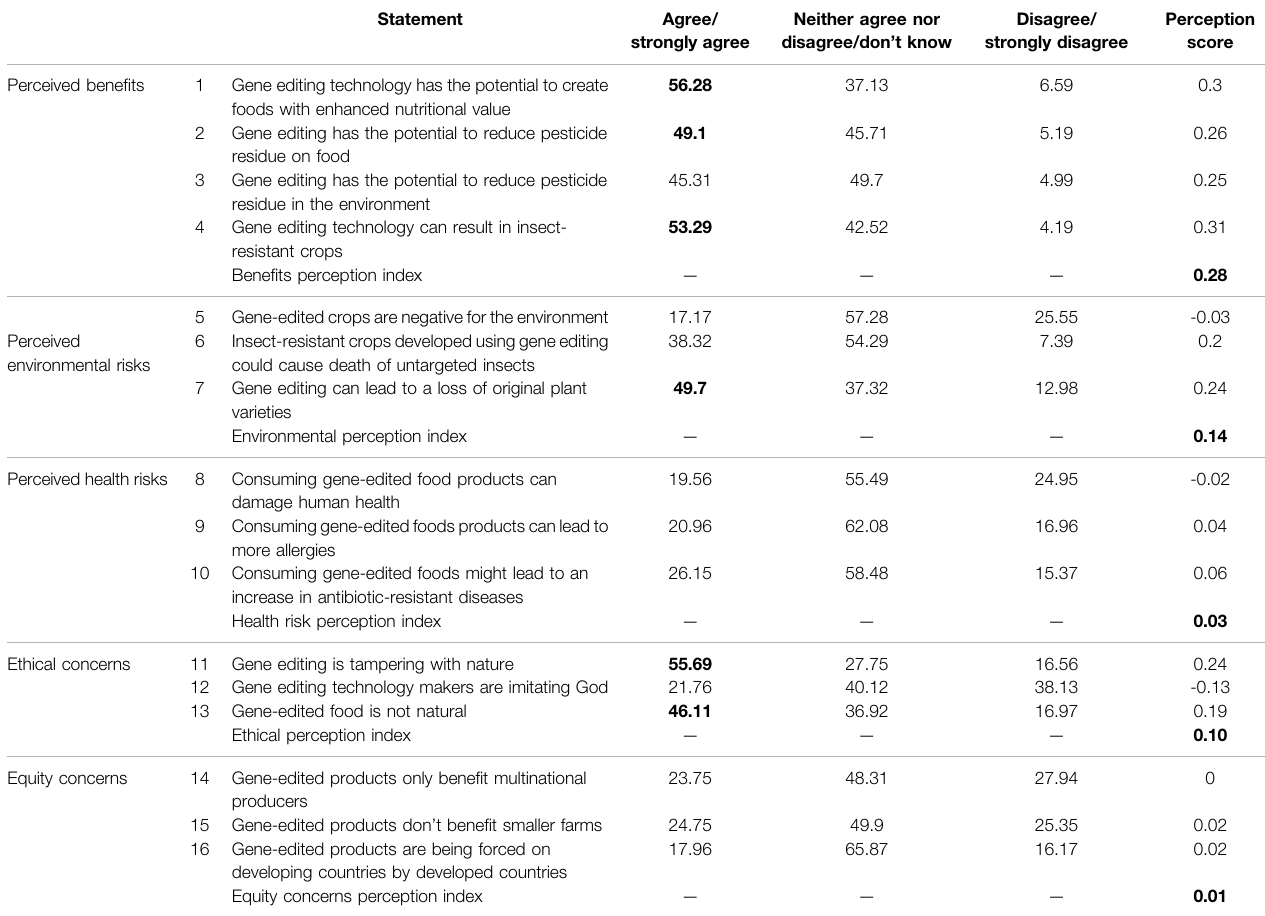
TABLE 3 | Bene fi ts and risk perception indices toward gene editing technology